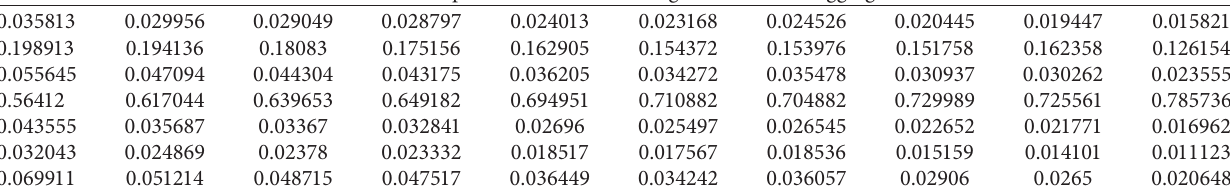
Table 4: The membership results of the FCM algorithm on the aggregation data set.